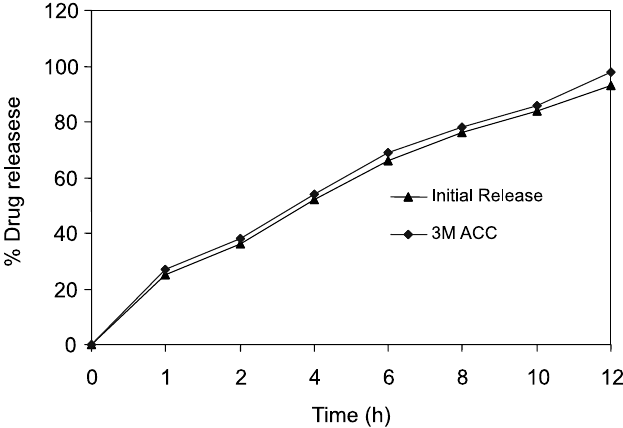
FIGURE 10 - In vitro drug release profile of tablets prepared using Sodium alginate-containing pellets during stability